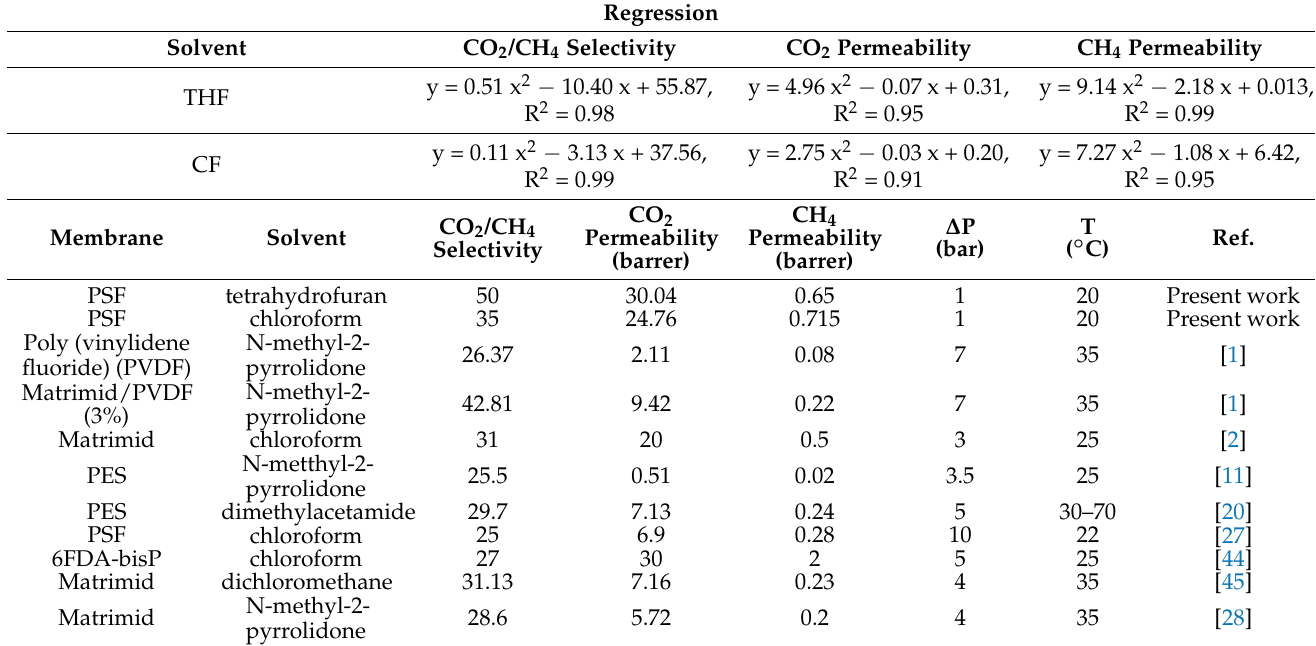
Table 2. Comparison of CO 2 /CH 4 mixed gas selectivity and permeability values with those from literature.